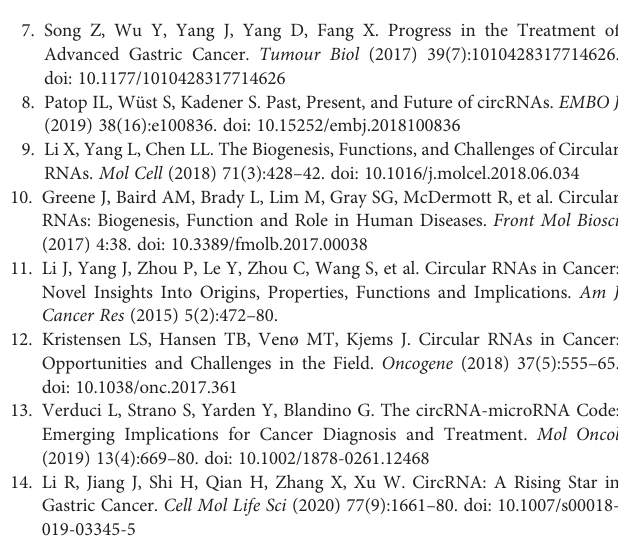
Supplementary Figure 1 | Overexpression of circPTK2 inhibits SNU-5 cell proliferation, migration and invasion. (A) SNU-5 cells were treated with circPTK2 shRNA2 or circPTK2-OE. Cell viability was measured by CCK-8 assay. (B) Cell proliferation was determined by colony formation staining assay. (C) Cell migration and cell invasion were measured by transwell assays. ** p < 0.01. The signi fi cance between four groups was analyzed by one-way